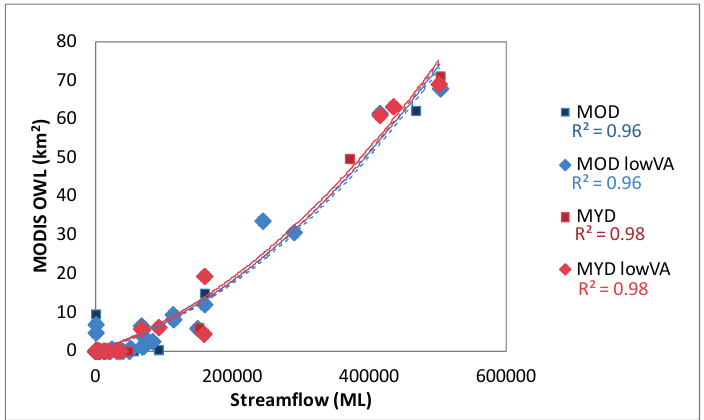
Figure 8. MODIS OWL flood extend plotted against streamflow for Site W1 for the 2003, 2004, 2009 and 2010 wet seasons. The data with a low view angle (lowVA), or range distance less than 1000 km, are shown in the large diamond shape.